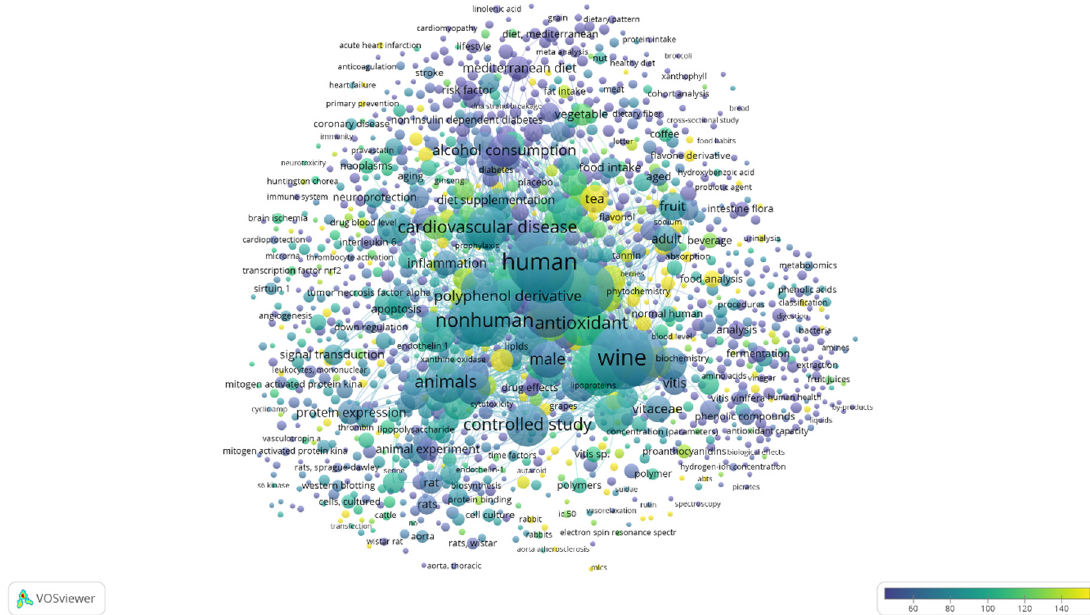
Figure 1. Term map for relationships of wine polyphenol and health research. Bubble size represents the number of publications. Bubble color represents the citations per publication (CPP). Two bubbles are closer to each other if the terms co-appeared more frequently. (Bibliometric data were extracted from the Scopus online database and elaborated by VOSviewer software).